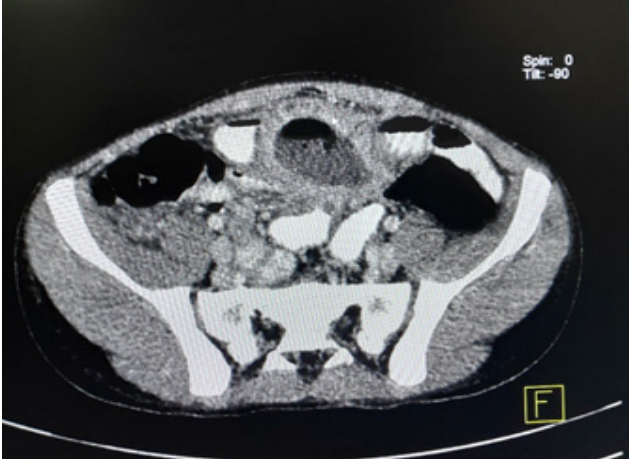
Fig. 3. Sections from the Meckel’s diverticulum showing ileal type epithelium lined by tall columnar cells admixed with goblet cells along with presence of all three layers of bowel wall